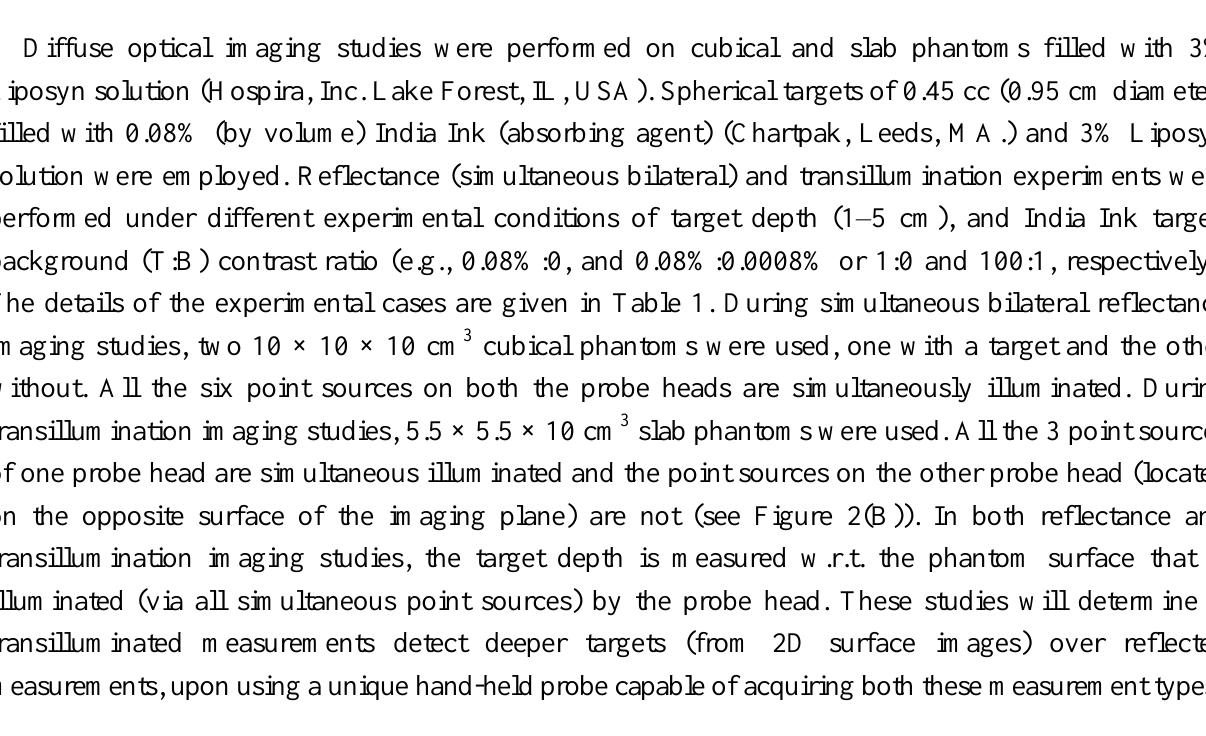
Figure 2. Schematic of experimental tissue phantom study set-up for ( A ) simultaneous bilateral reflectance imaging, and ( B ) transillumination